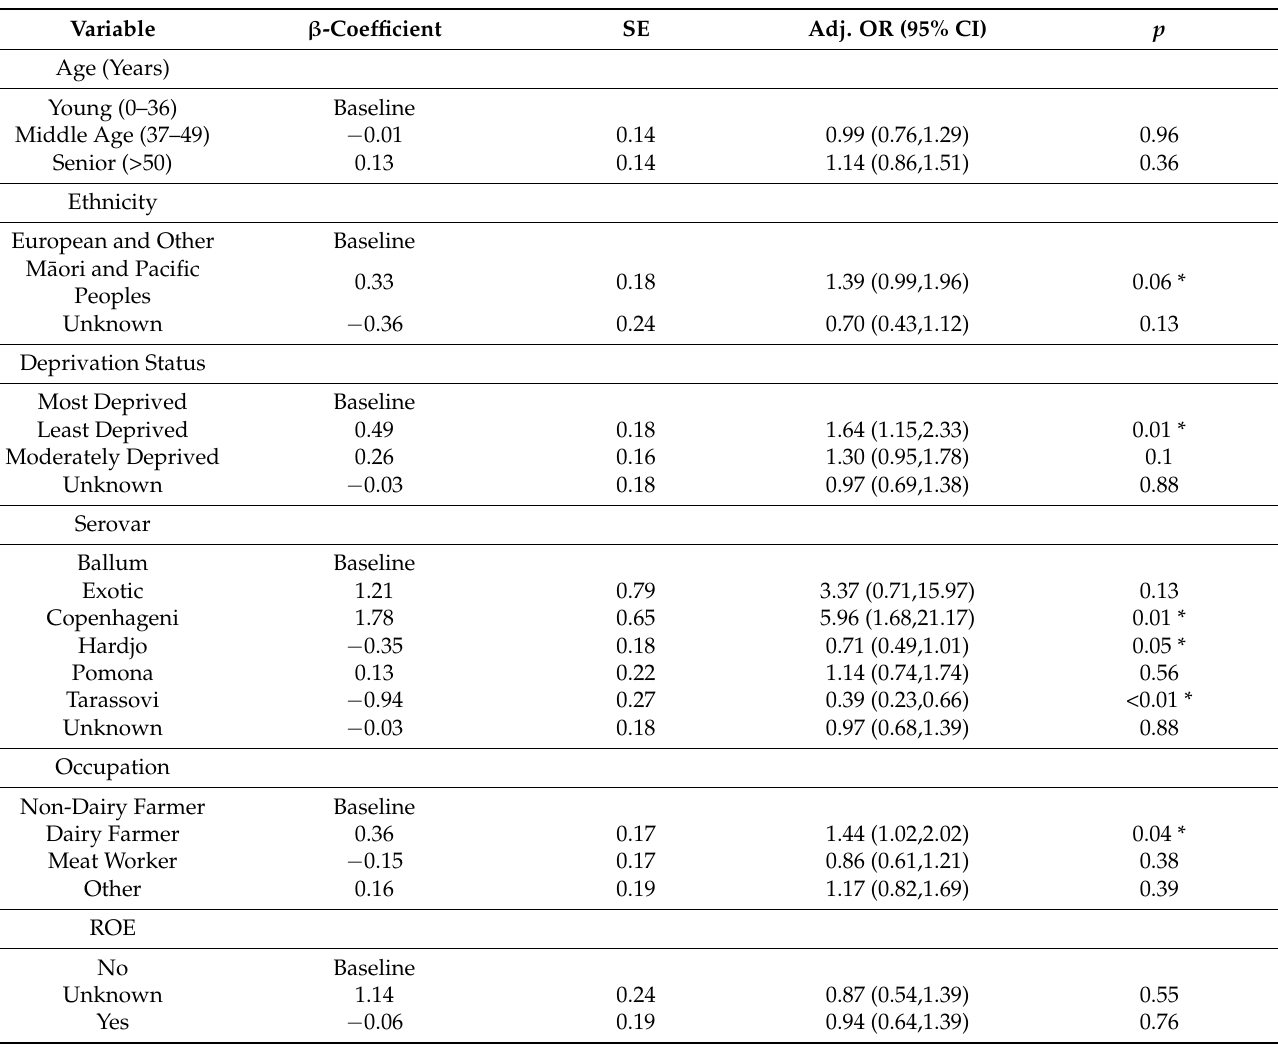
Figure 2. Hospitalised notified leptospirosis cases by year, New Zealand 1999–2017. Pink bars repre- sent the number of hospitalised cases, and the yellow line represents percentage of hospitalised cases. Table 4. Results from a multivariable logistic regression model of risk factors associated with hospitalisation amongst notified leptospirosis cases in New Zealand